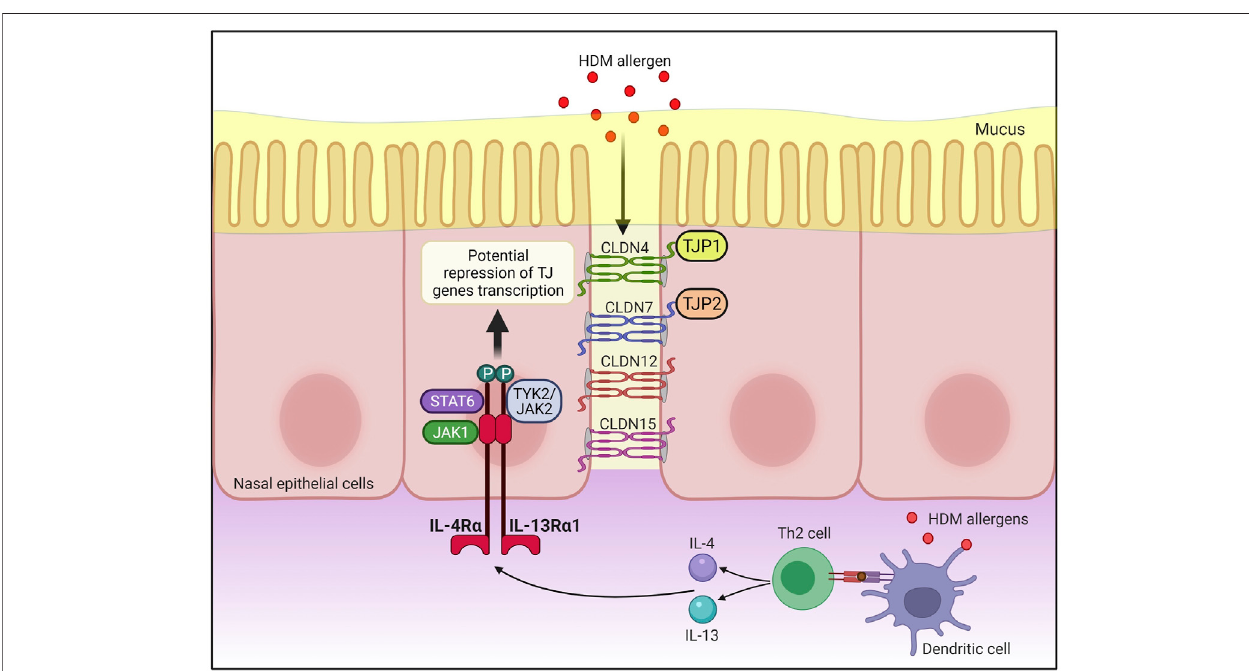
FIGURE 4 | Antigen presenting cells (APCs) such as dendritic cells uptake, process and present peptides from allergens on the major histocompatibility complex (MHC)classIImolecule.TheantigencomplexandtheMHCclassIImoleculeserveasaligandforTcellreceptorsonnaïveCD4 + Tcells,resultingindifferentiationofnaïve CD4 + T cells into allergen-speci fi c Th2 cell. Subsequently, IL-4 and IL-13 are produced by activated Th2 cells, allowing IL-4 and IL-13 to bind to IL-4R α /IL-13R α 1 heterodimeric receptor. This activates Janus kinase 1 (JAK1) on IL-4R α and TYK2/JAK2 on IL-13R α 1 which phosphorylates the tyrosine residues at the cytoplasmic tail of IL-4R α that in turn serves as docking sites for signal transducer and activator of transcription 6 (STAT6). Activated STAT6 may then repress the transcription of CLDN4 , CLDN7 , CLDN12 , CLDN15 , TJP1 , and TJP2 expression in the nasal epithelial cells ofAR patients.CLDN, claudin; HDM, house dust mite; JAK, Janus kinase; STAT6, signal transducer, and activator of transcription 6; Th2, T helper 2; TJP, tight junction protein; TJs, tight junctions; TYK, tyrosine kinase. Created with